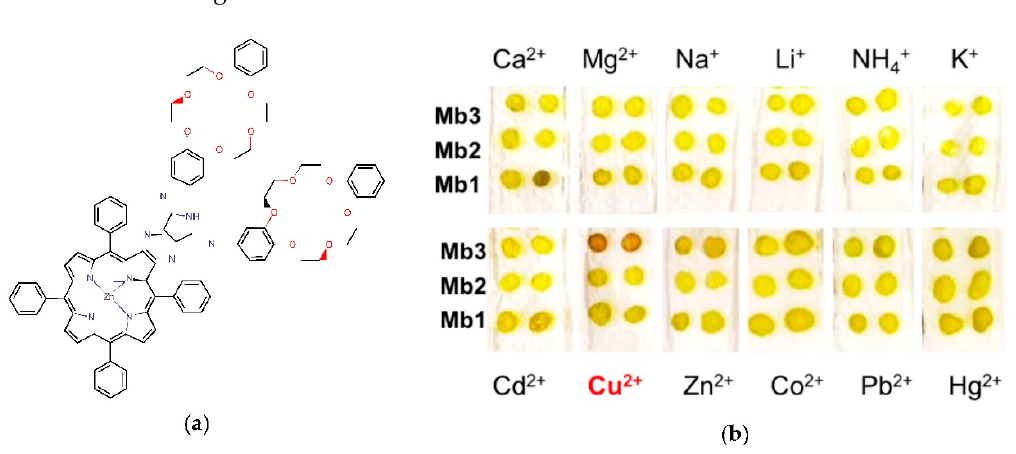
Figure 1. ( a ) Chemical structure of tested Zn(II)TPP-BPI-crown ligand, ZnPC; ( b ) The photograph of optode sensors after testing in different cations solutions in concentration range 6.6 × 10 − 7 to 2.4 × 10 − 2 mol/L. The measurements were done in 0.01 M HEPES pH 7.4 upon excitation with 380 nm